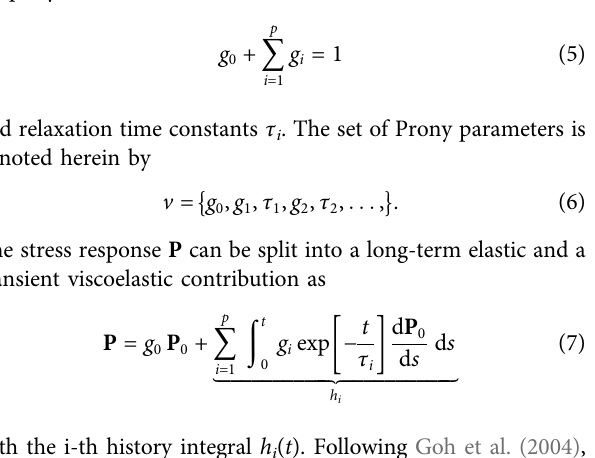
TABLE 3 | Proteins investigated by ELISA. Investigated protein Manufacturer Cat. nr ELISA type Detection range Glial fi brillary acidic